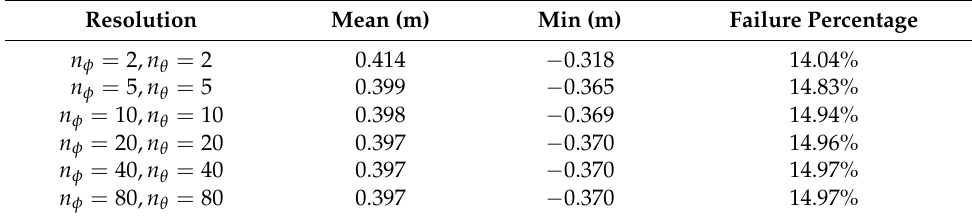
Table 2. Controllability Analysis Results For Different Disturbance Set